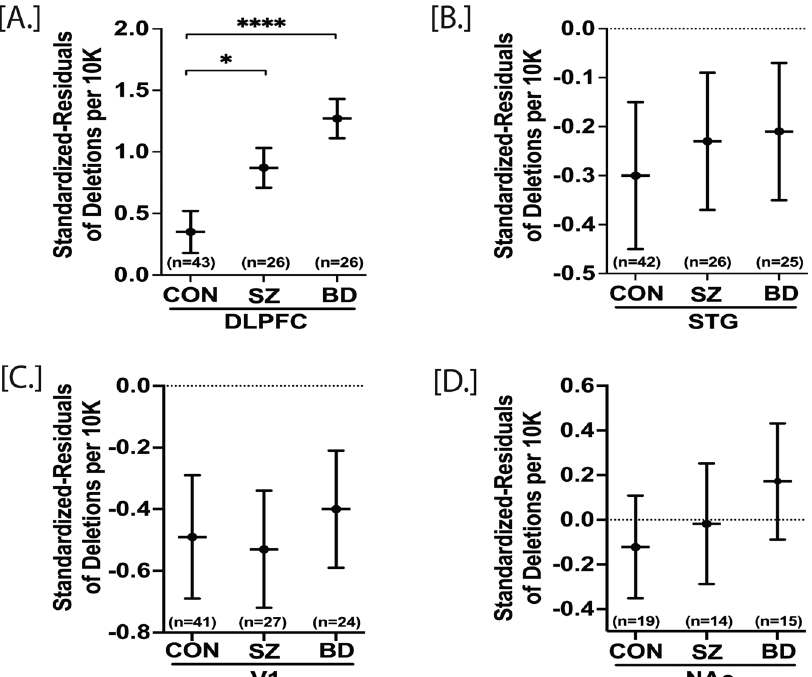
Fig. 3 Standardized residuals of deletions per 10 K in postmortem DLPFC, STG, V1, and NAc of control (CON), schizophrenia (SZ), and bipolar disorder (BD) groups. A repeated measure analysis was performed for statistical signi fi cance with adjustment of age and sex. DLPFC, STG, and V1 were analyzed together to obtain the regional correction, whereas NAc data were analyzed individually. DLPFC standardized residuals of deletion per 10 K were signi fi cantly higher in both SZ and BD compared to control group ( A ). There were no signi fi cant group differences in STG, V1, and NAc ( B – D ). Deletion levels are negative based on standardized residuals. All data are represented as least square mean (LSM) ± Std. error. p < 0.05 and p < 0.0001 are denoted by * and ****, respectively, otherwise p > 0.05.